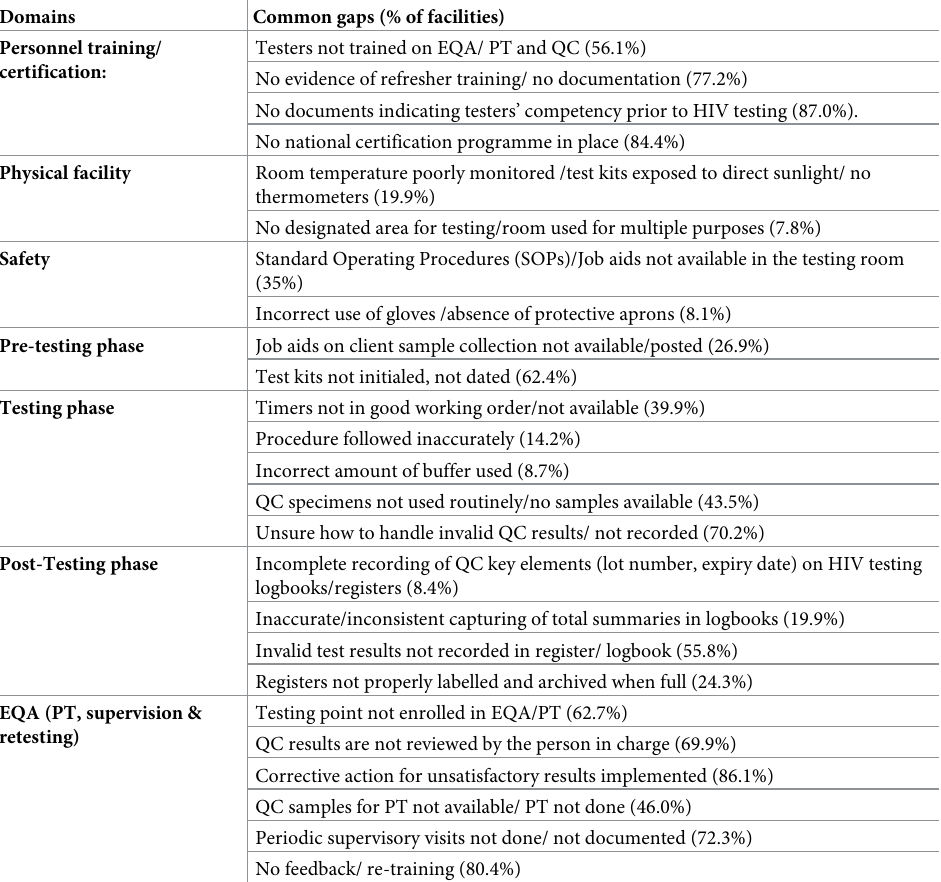
Table 6. Commonly identified deficiencies: Quality of HIV rapid testing practices, South Africa.